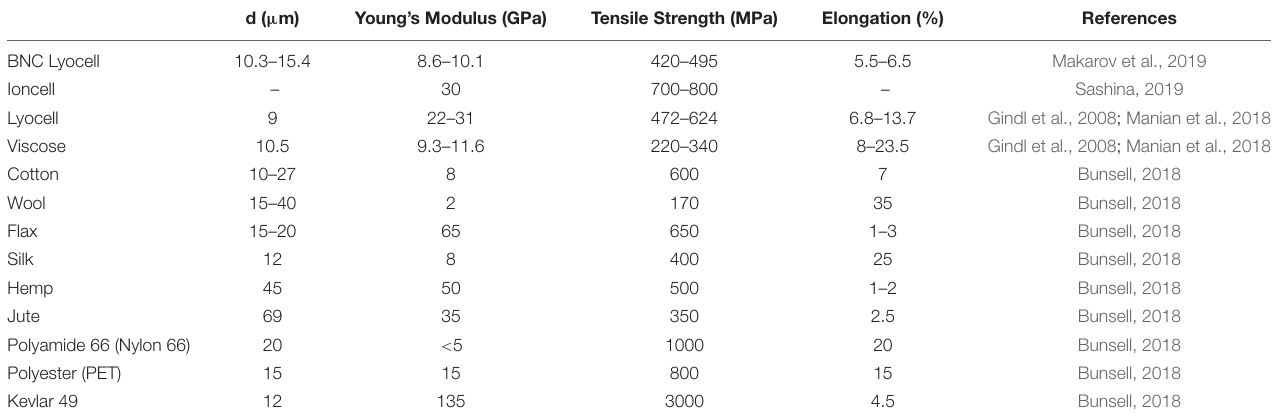
TABLE 1 | Mechanical properties of different fibers. d ( µ m) Young’s Modulus (GPa) Tensile Strength (MPa) Elongation